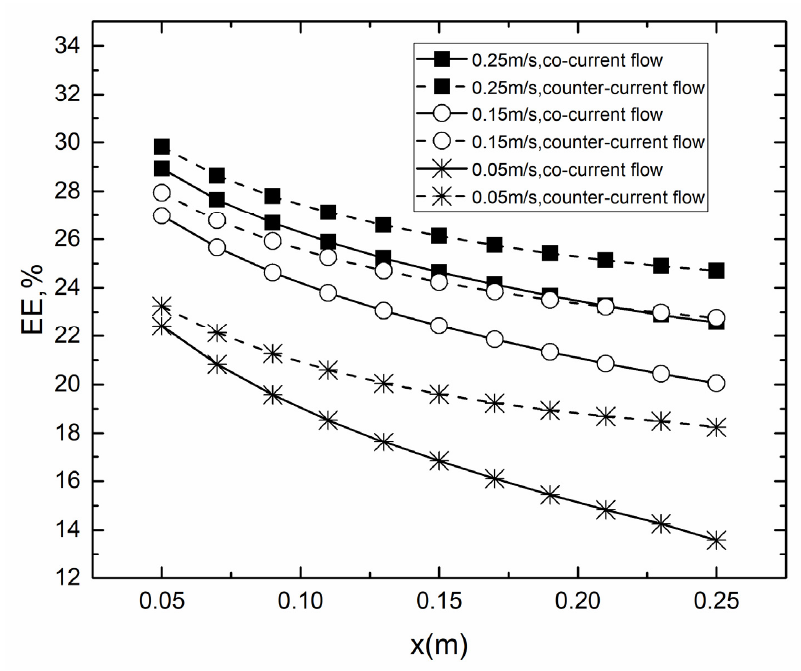
Figure 10. EE for co- and counter-current operations in different v f , v p . ( T f = 45 °C, T p = 25 °C, c f = 24.2 wt.%).